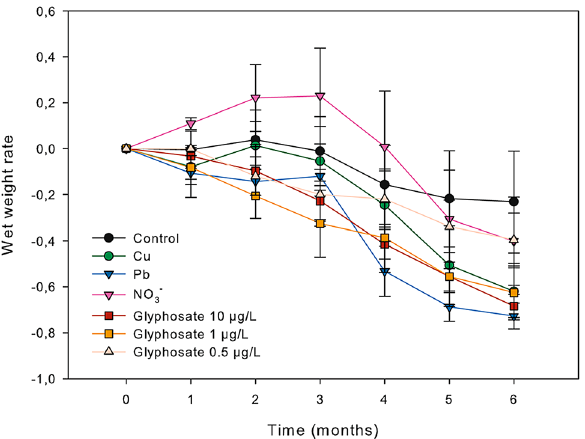
Figure 2. Mean wet weight variation of adult individuals of Carpodesmia crinita under control and the different pollutant conditions over a period of 6 months. Weight variation is given in parts per unit. Vertical bars represent standard